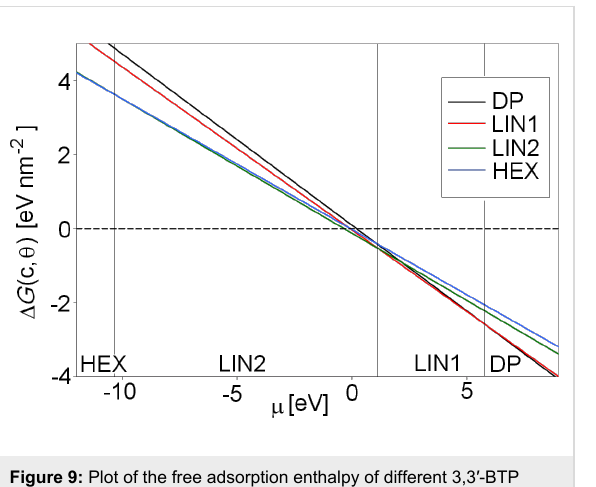
Figure 9: Plot of the free adsorption enthalpy of different 3,3 ′ -BTP phases against the chemical potential obtained with fully solvated surface structures by using the Compass force